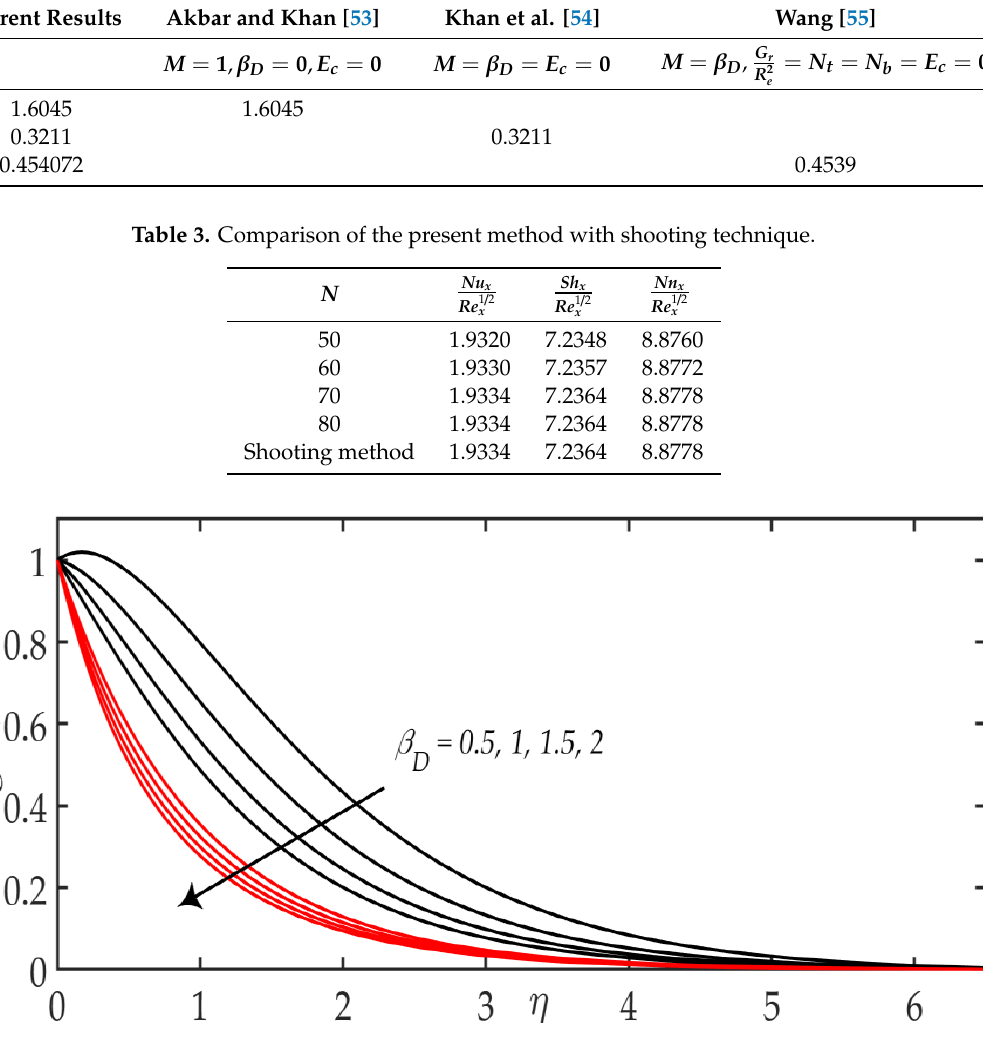
Figure 2. Variation of β D and M on velocity distribution. Black line: M = 0, Red line: M = 3.